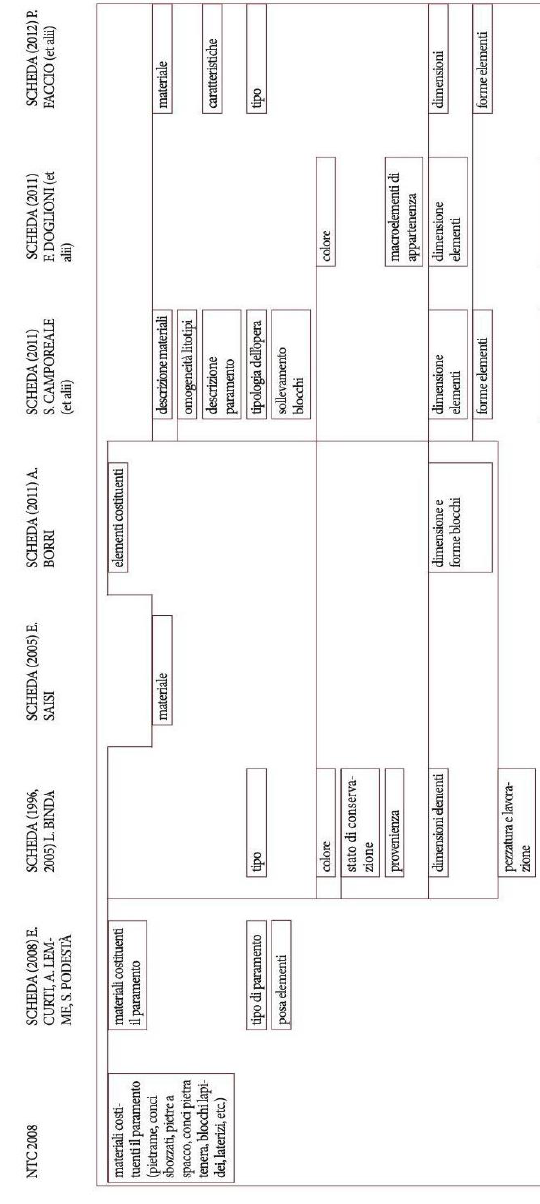
Figure 2. Synoptic map of survey forms.